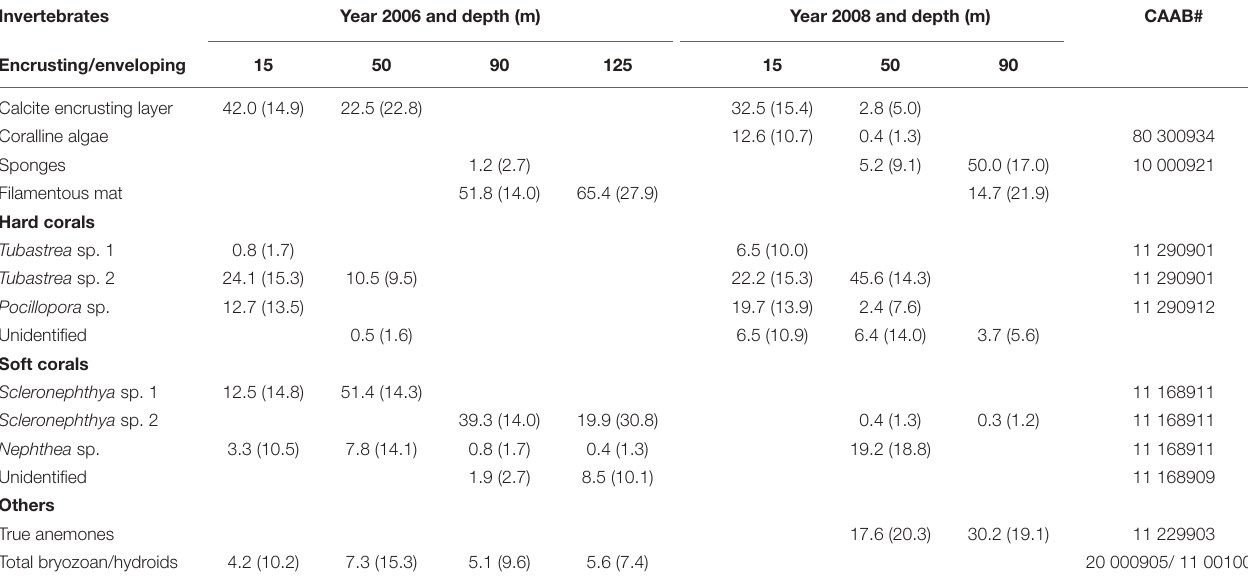
TABLE 1 | Invertebrate taxa and their mean percent cover on the horizontal members of Goodwyn Alpha platform in 2006 and 2008 (standard deviation shown in brackets). Invertebrates